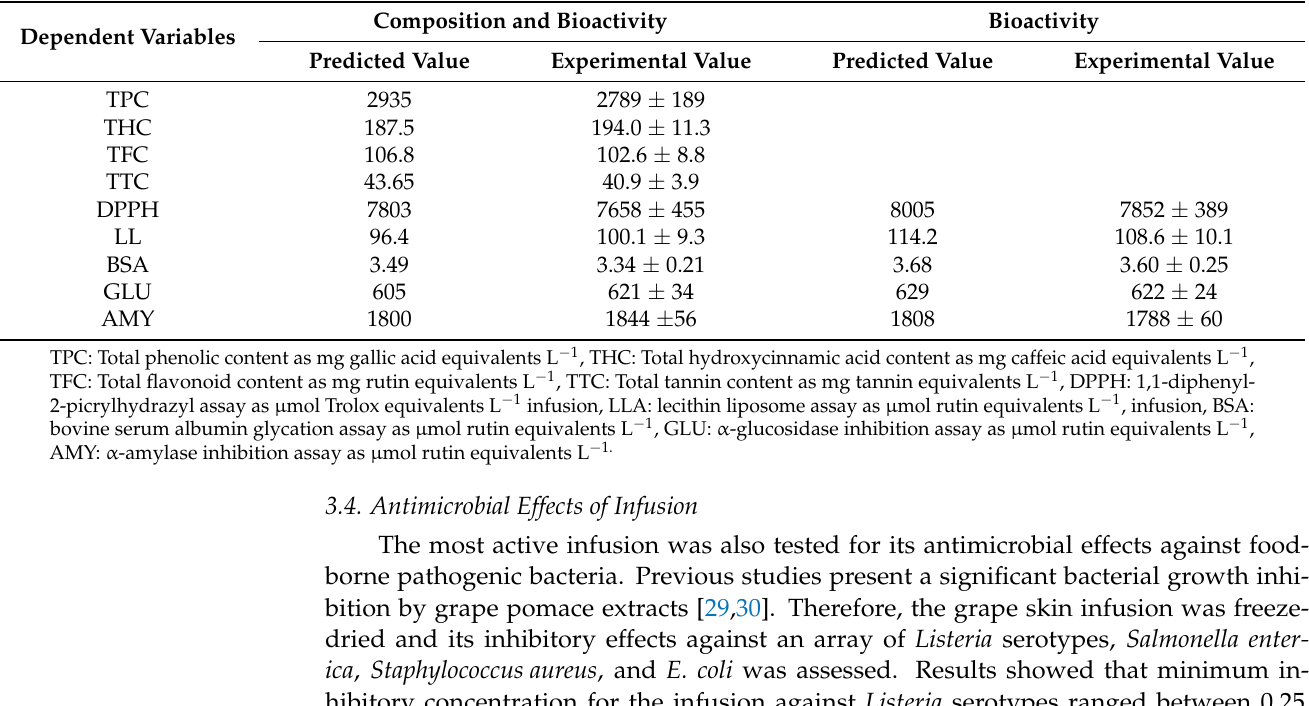
Table 4. Experimental and predicted values for phenolic composition and bioactivity in optimized grape pomace infusion. Composition and Bioactivity Dependent Variables